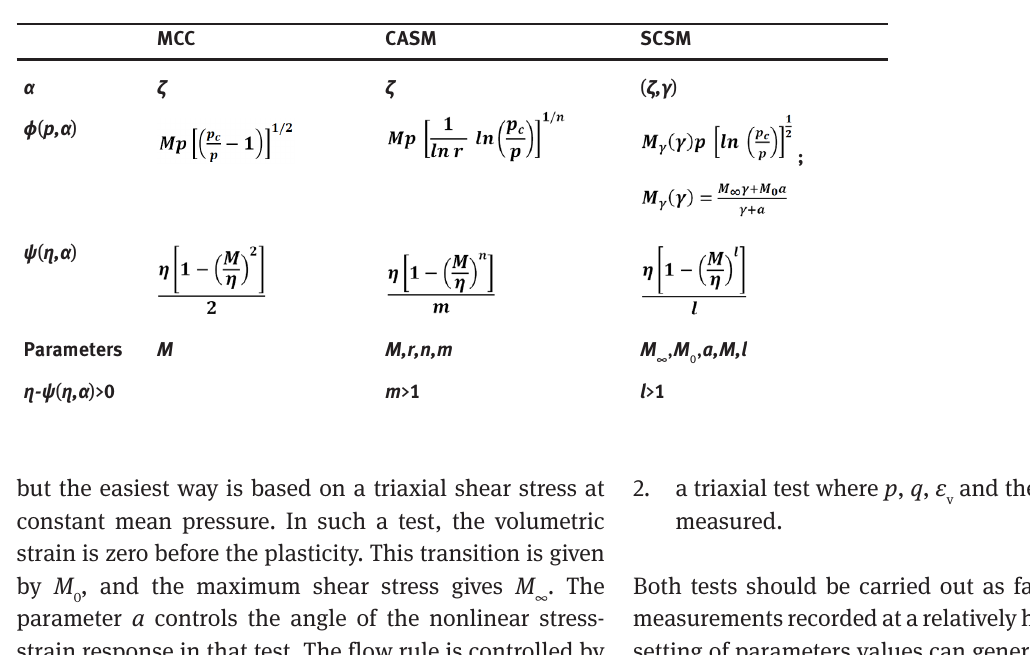
(b) Variation of the model’s response with Figure 4: Response of a drained triaxial test Figure 4: Response of a drained triaxial test. Table 2: Studied models standardized